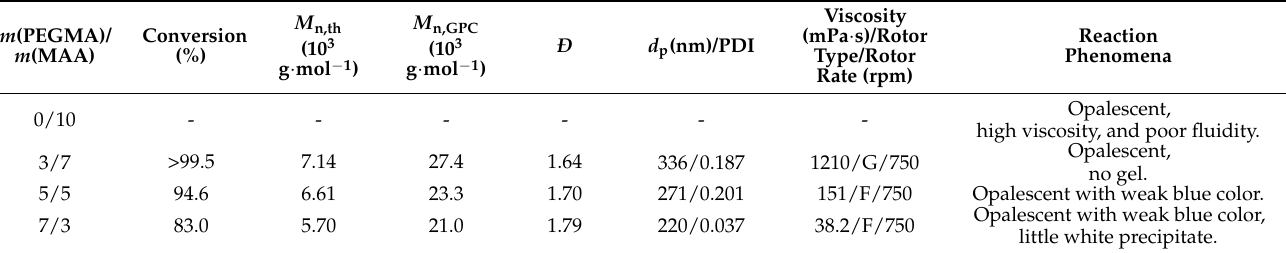
Table 3. Results of emulsion with PEGMA units in polymer